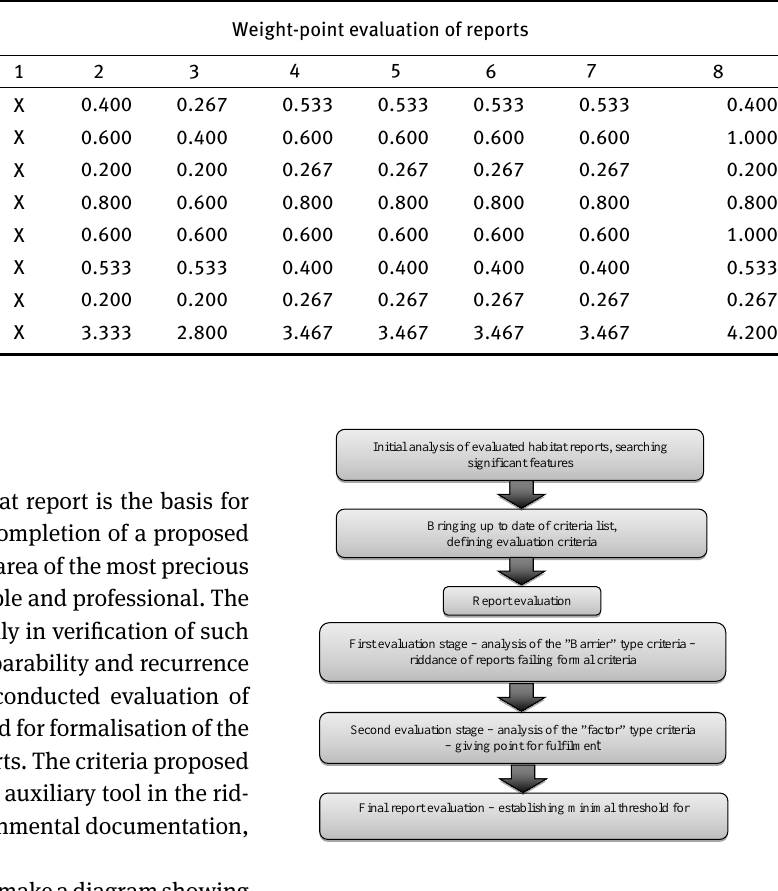
Figure 1: Diagram of activities using the defined criteria and the proposed